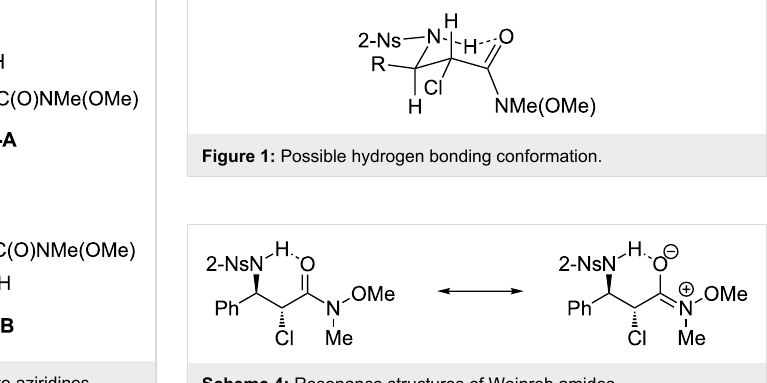
Scheme 4: Resonance structures of Weinreb amides.